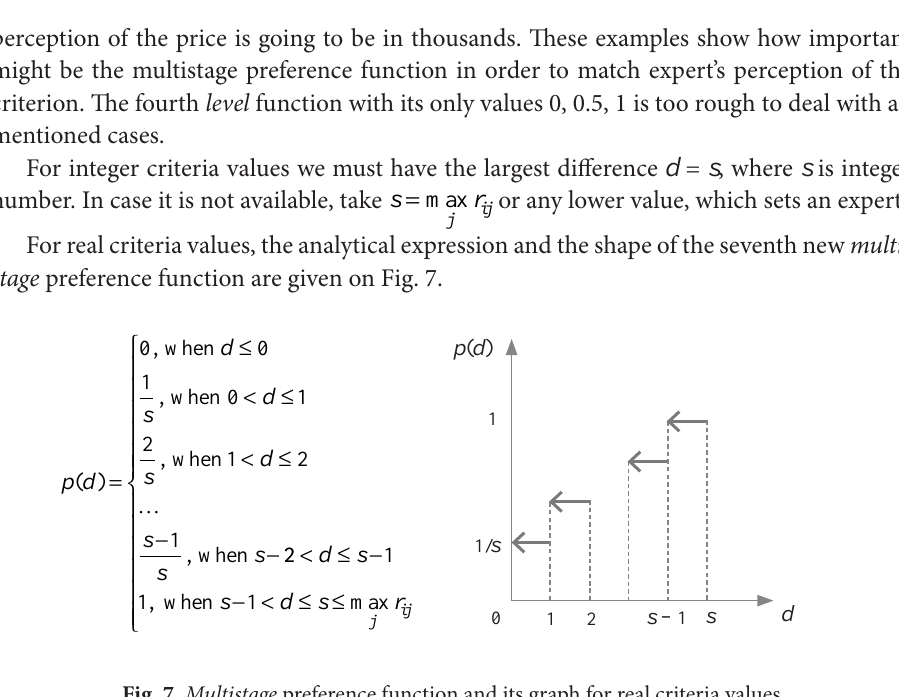
Fig. 7. Multistage preference function and its graph for real criteria